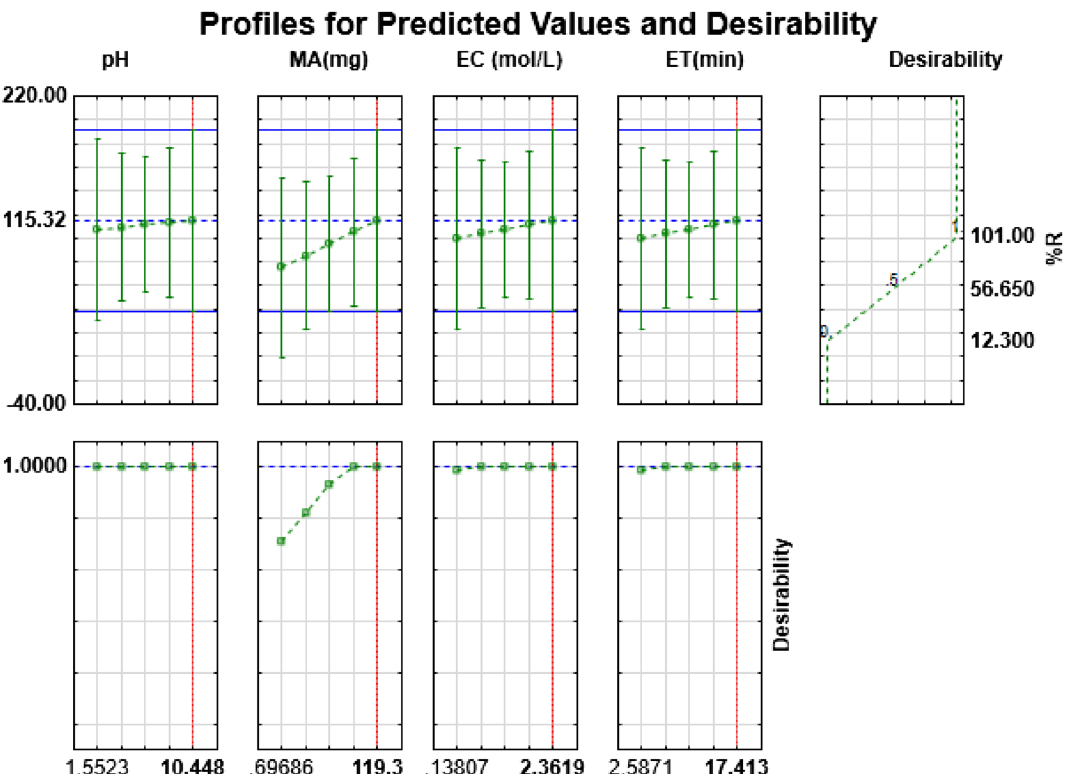
Figure 8. Profile for the predicted values and desirability function for the removal percentages of As(III), Cd(II), Cr(III), Co(II), Ni(II), and Pb(II)